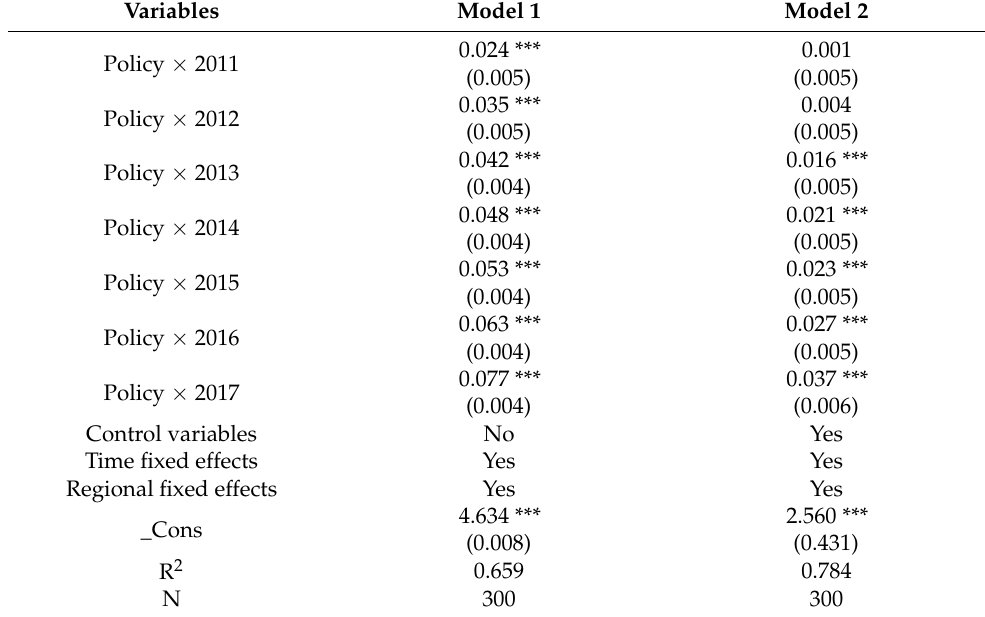
Table 4. Dynamic effects of the policy.